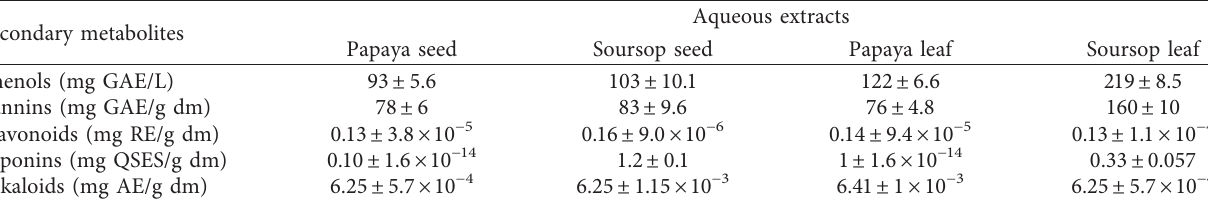
Table 3: Quantification of secondary metabolites present in aqueous extracts of papaya and soursop seed and leaf. Secondary